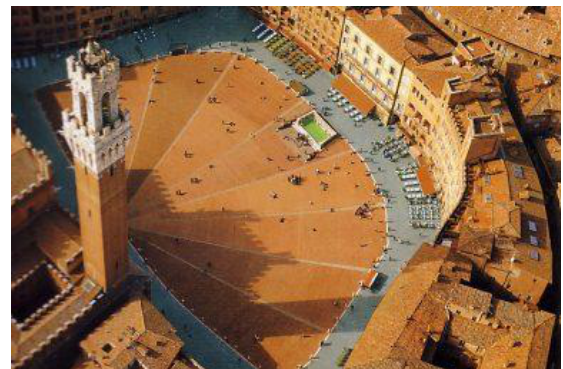
Figure 10. Objective organization of space elements affects on spatial